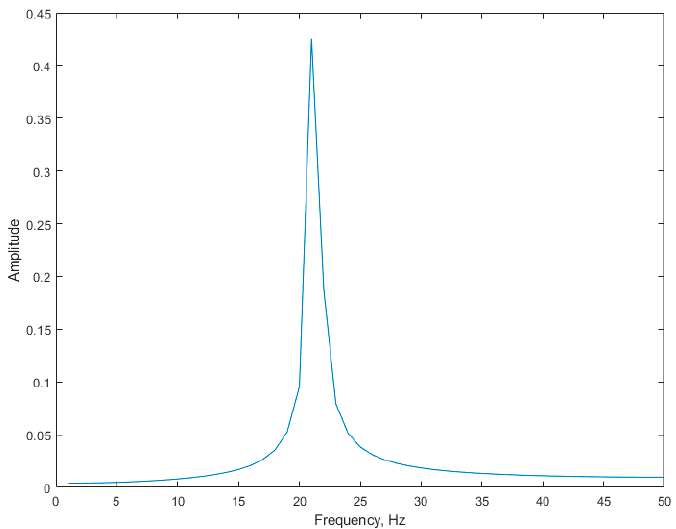
Figure 14. Spectrum of mono-harmonic signal with 20.3 Hz.